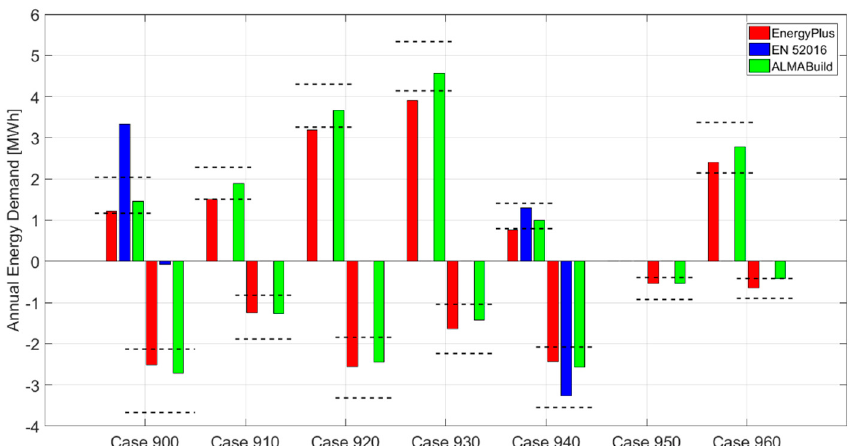
Figure 9. Comparison of the annual energy demand (MWh) predicted by EnergyPlus, the Standard EN 52016 and ALMABuild for heavyweight BESTEST buildings.